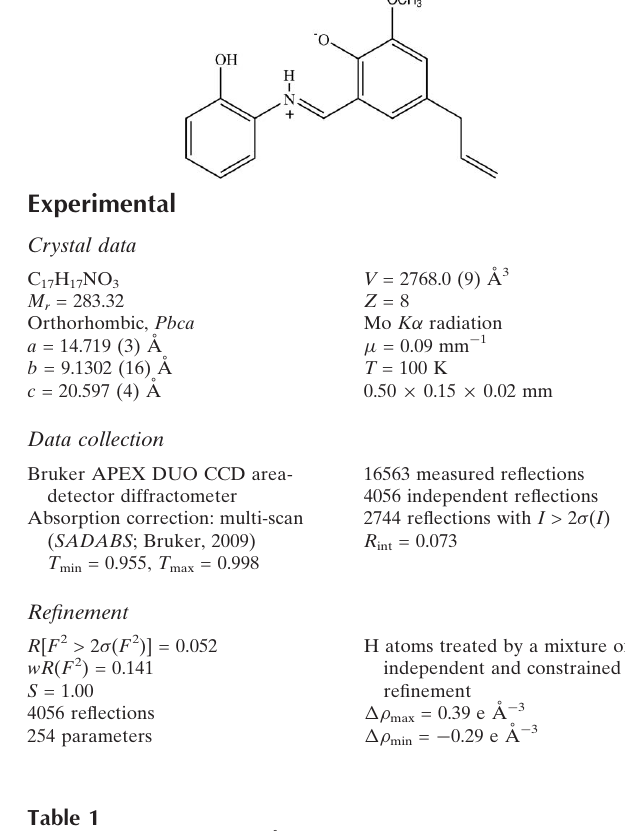
Hydrogen-bond geometry (A˚ , (cid:2) ). Cg 1 is the centroid of the C8–C13